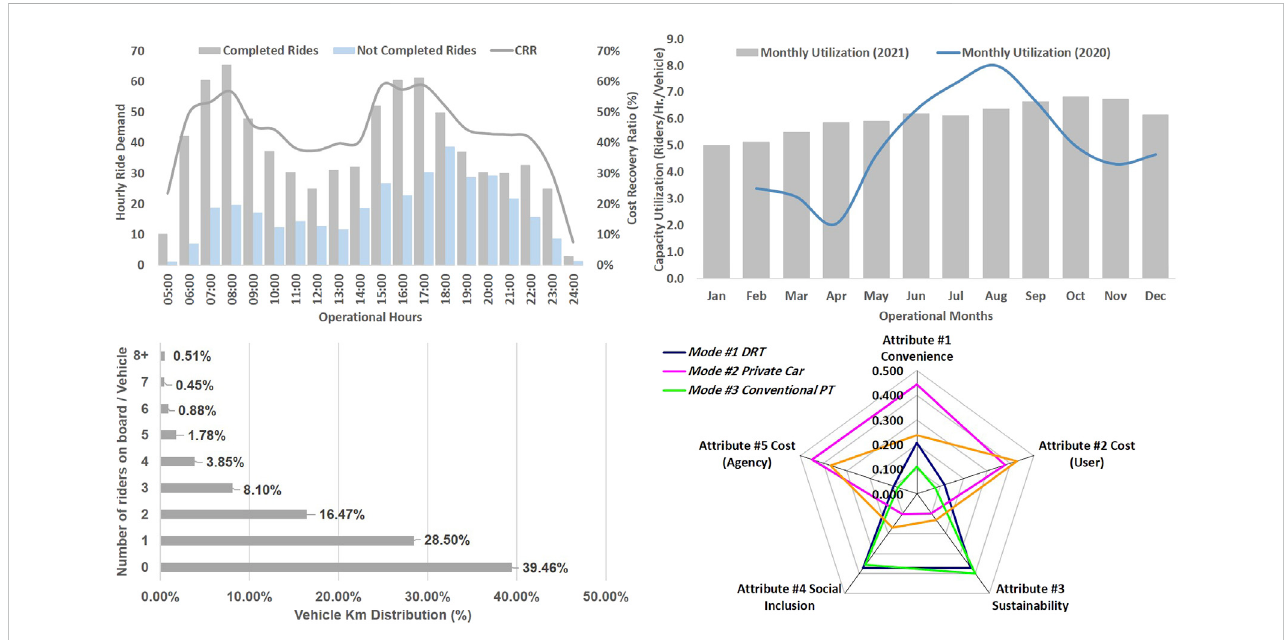
FIGURE 2 Operational parameters of DBOD (Source: DBOD operational